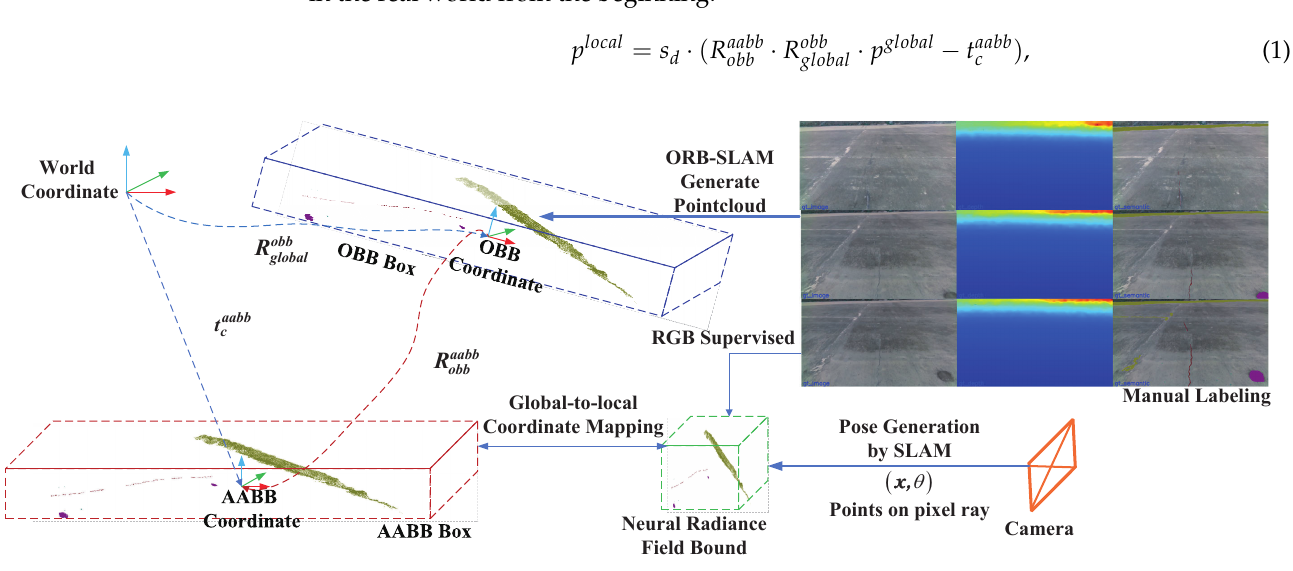
Figure 4. Global-to-local coordinate mapping. Establish our global-to-local inspection methods. After collecting surface RGB-D images, we label surface defects as shown in the right column using the same color as Figure 3. Using ORB-SLAM to generate images pose and global point cloud and register labeled images to point cloud. After that, use Equation (1) to transform points from the global coordinate to AABB coordinate. Finally, scale the AABB box to the neural radiance field bounding box. (The coordinate origins of OBB box and AABB box are coincident. For the convenience of observation, they are drawn separately in the